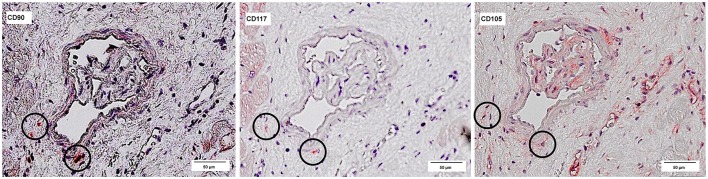
Co-expression of CD90, CD117, and CD105. Three serial sections of the same patient (Patient 4) are stained with different antibodies: CD90, CD117, and CD105. The circles mark cells, which are positive for all three antibodies.